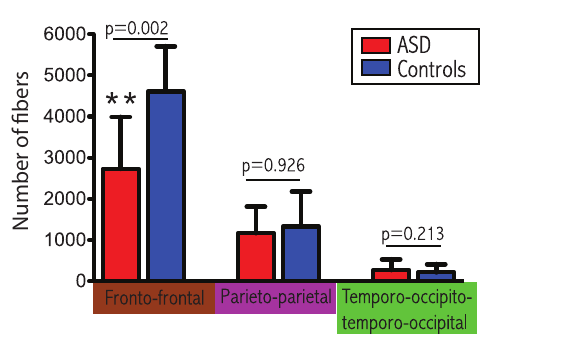
for age and gender). (C) Example of tractographic reconstruction where the inter-hemispheric fibers are subdivided into three groups according to the cortical regions that they connect. (D) Boxplots comparing the number of streamlines connecting homologous lobes. The p -values are extracted from the MANCOVA (correction for age, gender and total number of